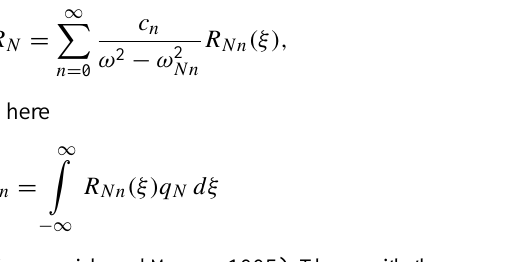
Fig. 4. Structure of the wave field across magnetic shells: a) for t = 1000 s (10 periods approximately) after the impulse, b) for t = 10000 s ( ∼ 100 periods) after the impulse.